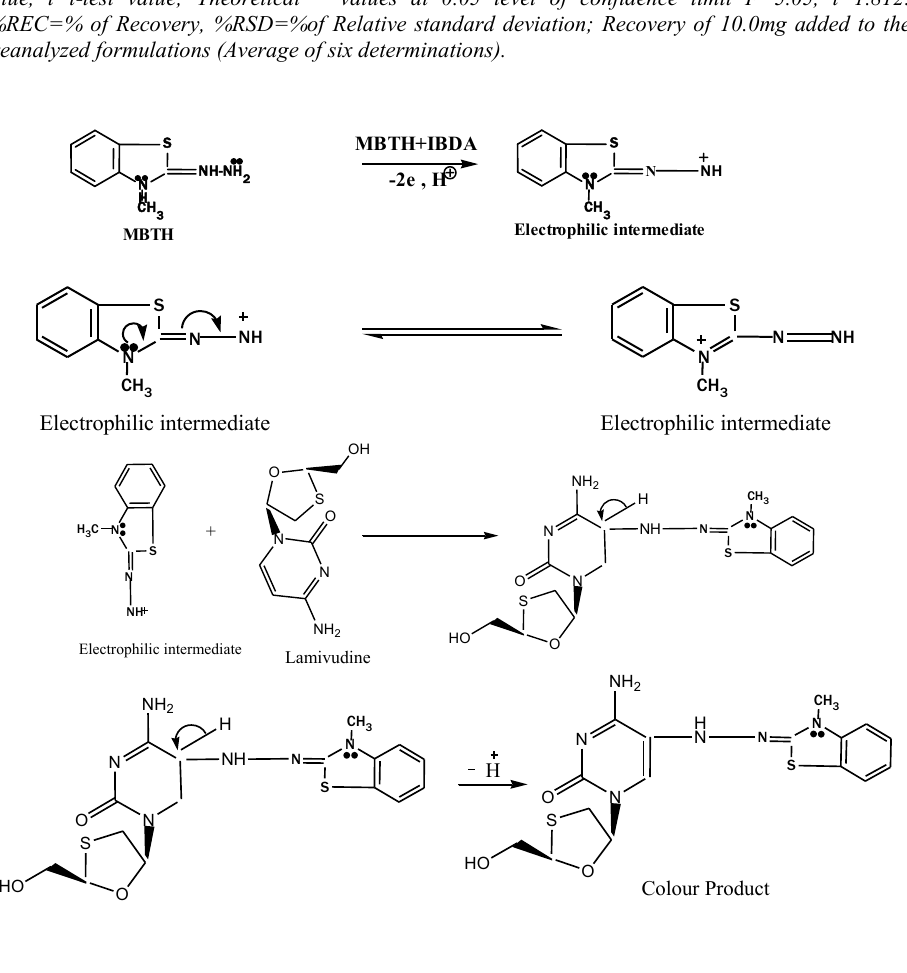
a Average of six determinations are considered, AVG=Average, SD=Standard deviation, F=F-test value, t=t-test value;